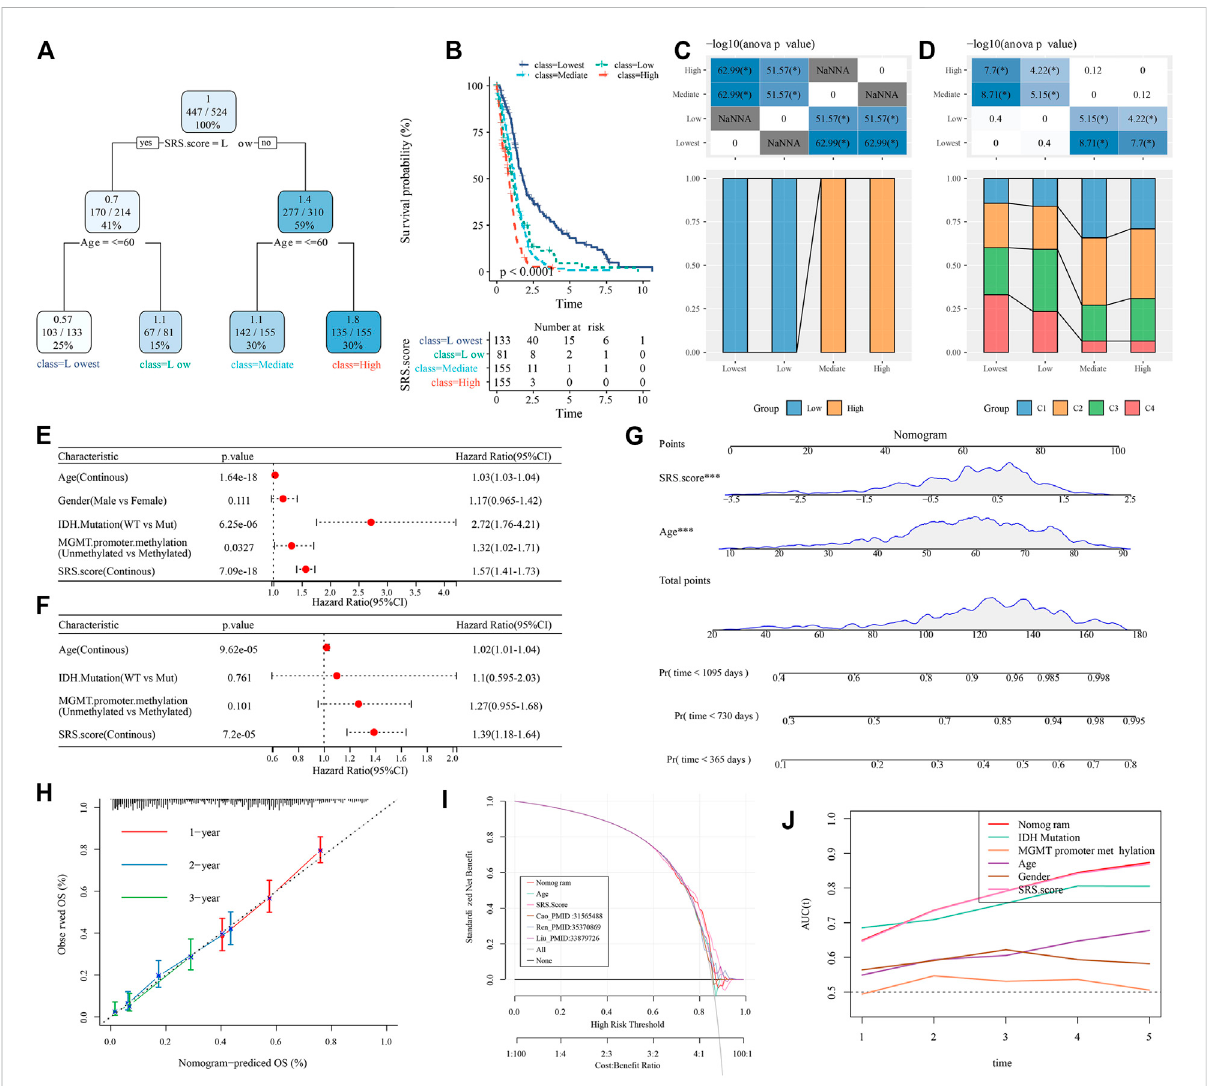
FIGURE 11 IdentifytheclinicalfeaturesthathavethegreatestimpactonprognosisinGBM. (A) Patientswithfull-scaleannotationsincludingSRS.Score,age, gender , IDH.Mutation and MGMT.promoter.methylation were used to build a survival decision tree to optimize risk strati fi cation; (B) Signi fi cant differences of overall survival were observed among the four risk subgroups; (C,D) Comparative analysis in subgroups; (E,F) Univariate and multivariateanalysisofSRS.scoreandotherclinicalfeatures; (G) NomogrammodelofSRS.Scoreandage; (H) 1-,2-and3-yearcalibrationcurves for nomograms; (I) Decision curve of nomogram; (J) Nomograms showed the strongest viability